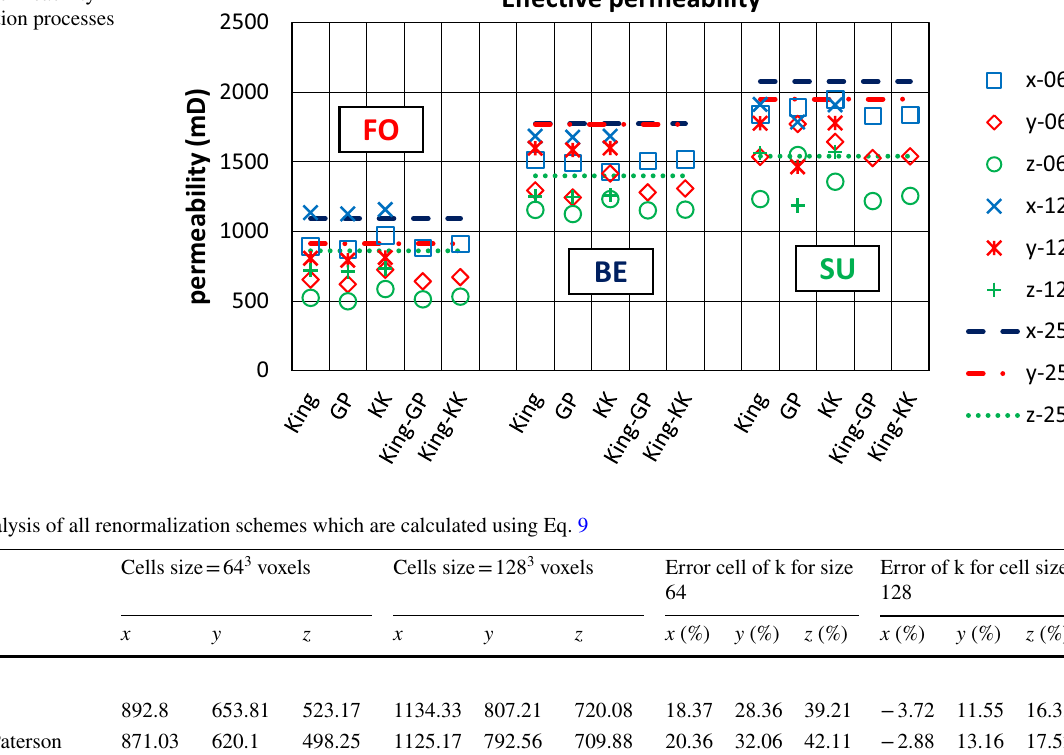
Fig. 7 Effective permeability after renormalization processes